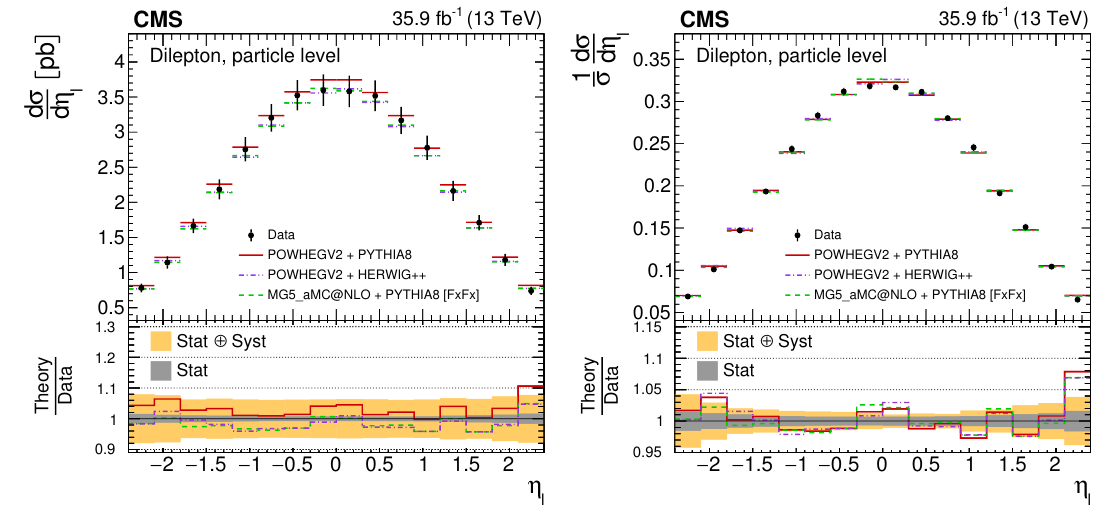
Figure 37 . The di(cid:11)erential tt production cross sections as a function of (cid:17) ‘ in a (cid:12)ducial phase space at the particle level are shown for the data (points) and the MC predictions (lines). The vertical lines on the points indicate the total uncertainty in the data. The left and right plots correspond to absolute and normalised measurements, respectively. The lower panel in each plot shows the ratios of the theoretical predictions to the data. The dark and light bands show the relative statistical and total uncertainties in the data, respectively.